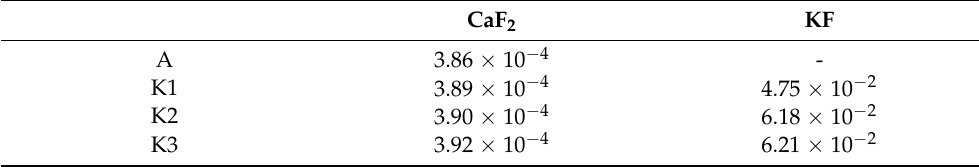
Table 3. The vapor pressure of A-K3 calculated at 1500 ◦ C using FactSage 8.0